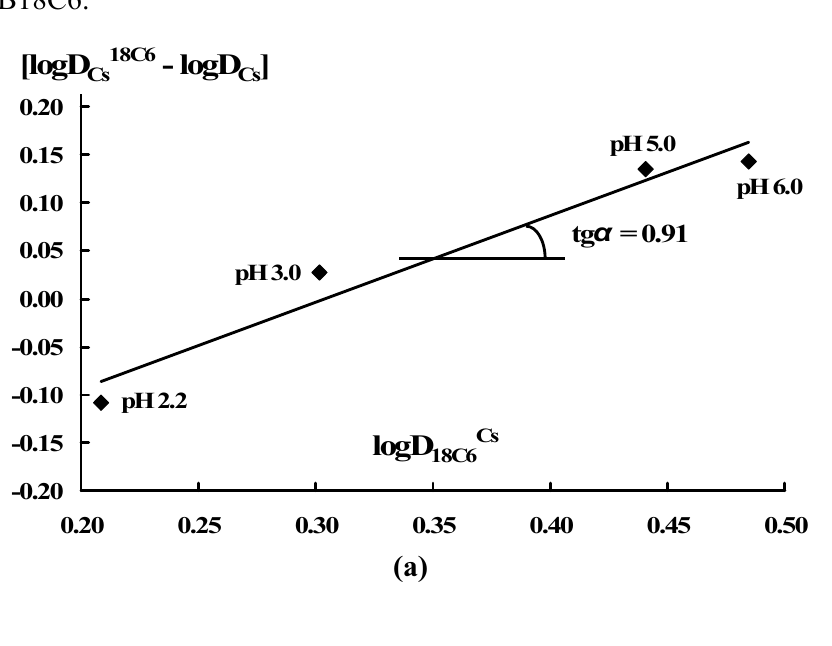
] vs. logD CECs for TOMAS at 22 °C. (a) CE = 18C6; Cs